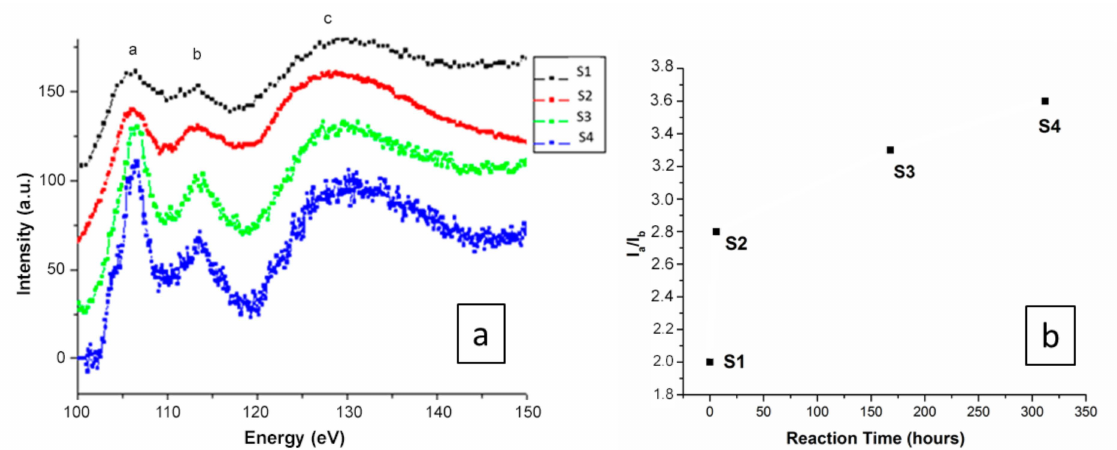
Figure 4. ( a ) Electron energy loss spectra of the Si L 2,3 edges obtained for all compounds / reaction times. Data were normalized to the L 3 maximum intensity. ( b ) Evolution of the intensity ratio of the peaks a to b deduced from the Si L 2,3 electron energy loss spectroscopy (EELS)